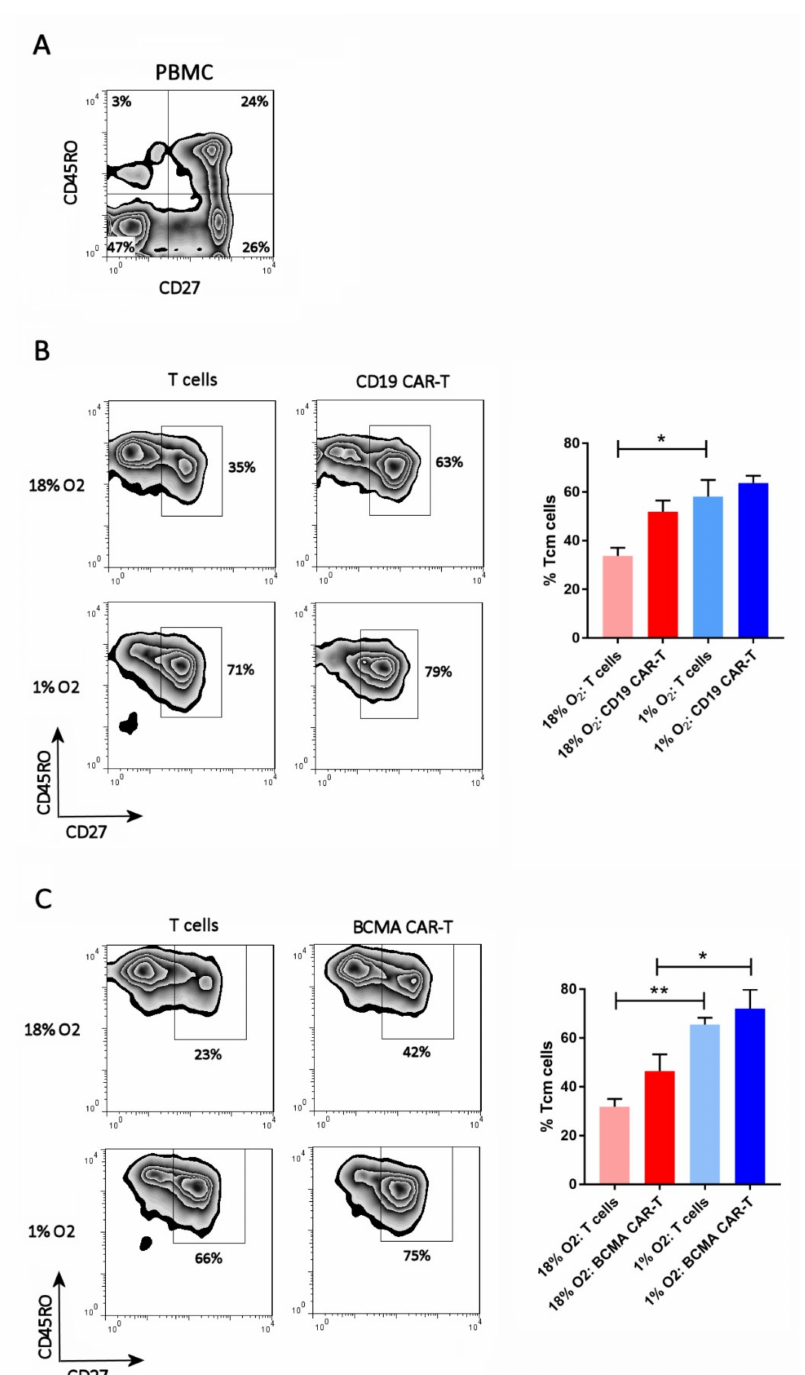
Figure 3. Hypoxia inhibits CAR-T cell di ff erentiation. PBMC ( A ), CD19 CAR-T cells ( B ) and BCMA CAR-T cells ( C ) were stained with antibodies for CD27 and CD45RO. CAR-T cells were first gated using the anti-FLAG antibody or BCMA protein. Representative flow cytometry plots showing CD27 and CD45RO expression are on the left; the CAR-T plots show only the gated CAR-T cells. Charts showing the average and standard error of 4 separate experiments are shown on the right. * p < 0.05 and ** p <